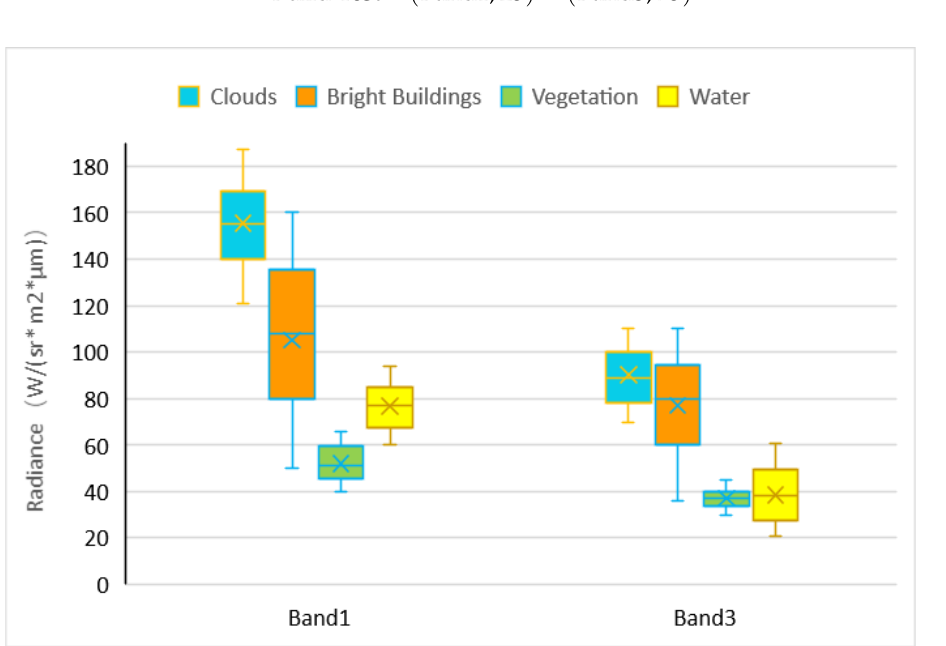
Figure 2. Boxplots of band 1 and band 3 radiances for clouds and various surfaces.